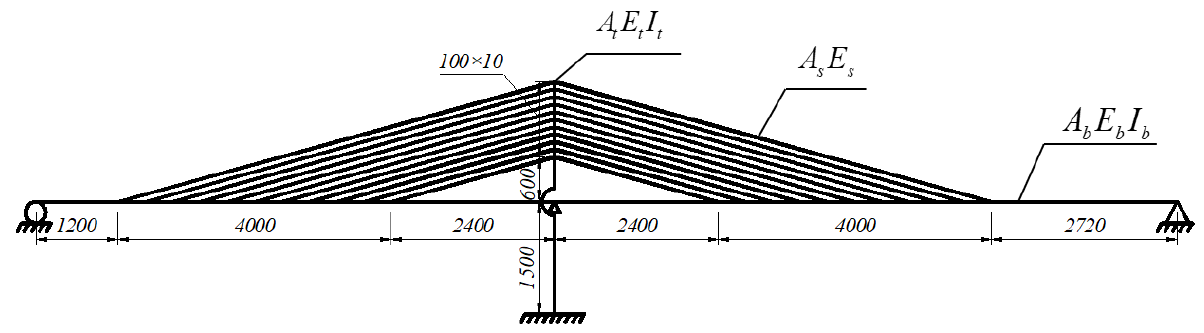
Figure 1. Configuration of the basic model (unit: cm).